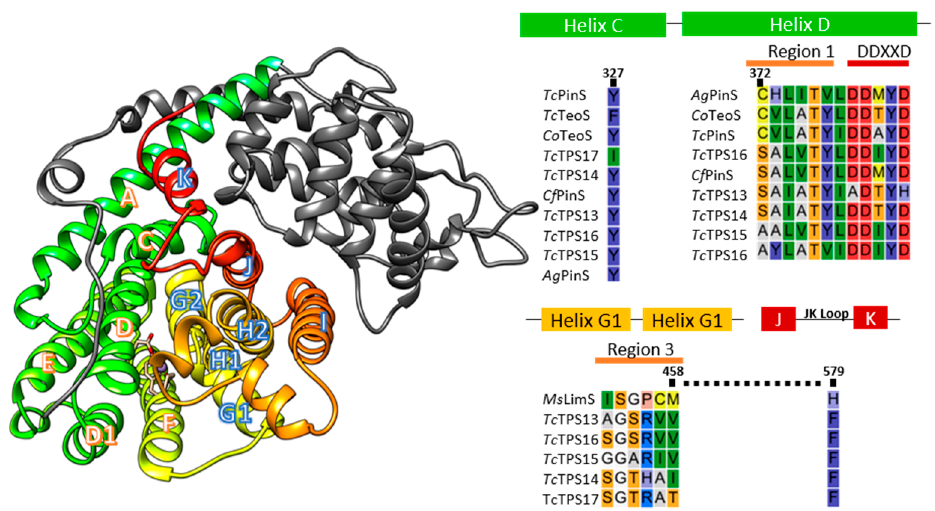
Figure 5. The protein structure of Tc TPS13 (model template ID: 2onh.1. A) and catalytic residue alignment. Helixes A to K and their related locations are illustrated in the left panel. The full alignment is illustrated in Figure S1.